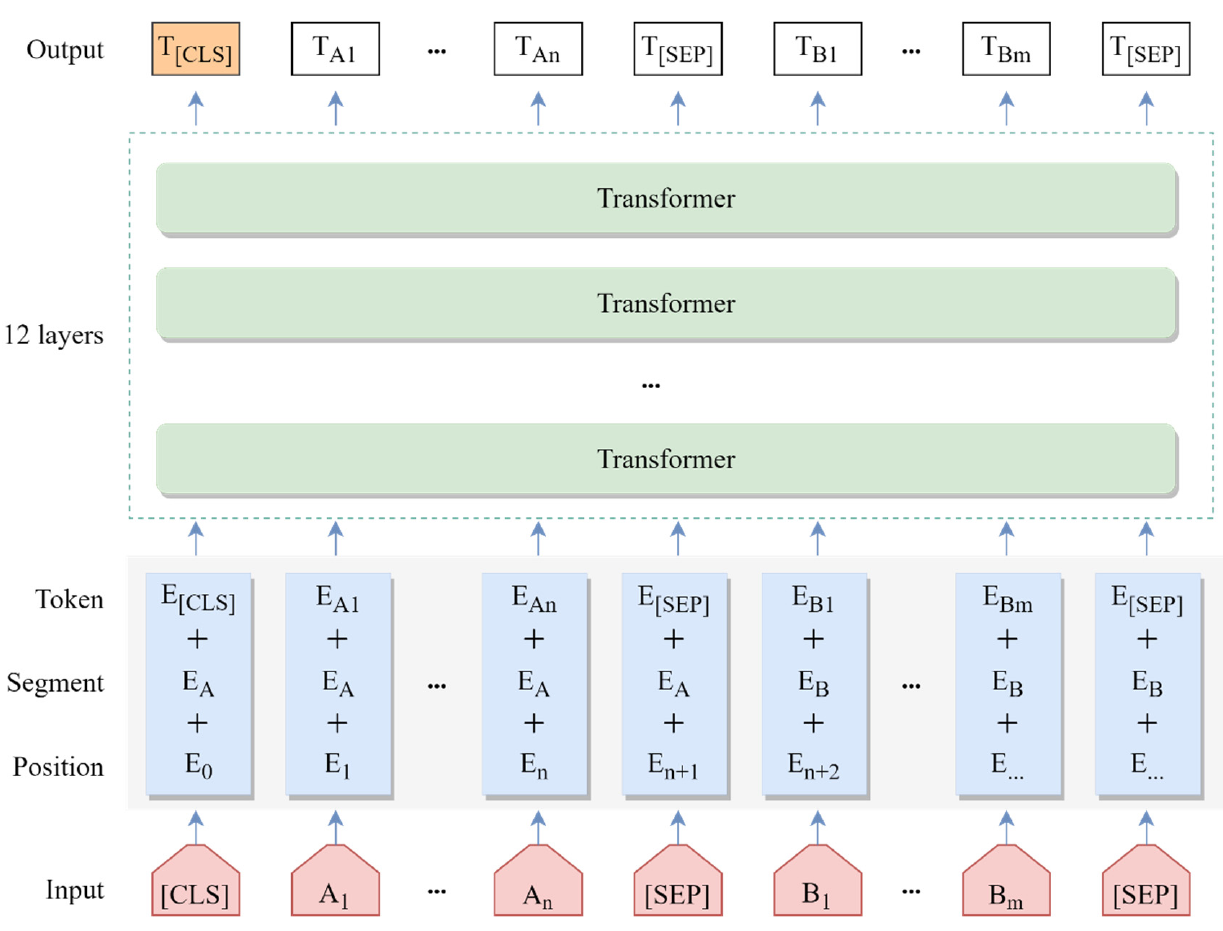
Figure 2. The model of RoBERTa.